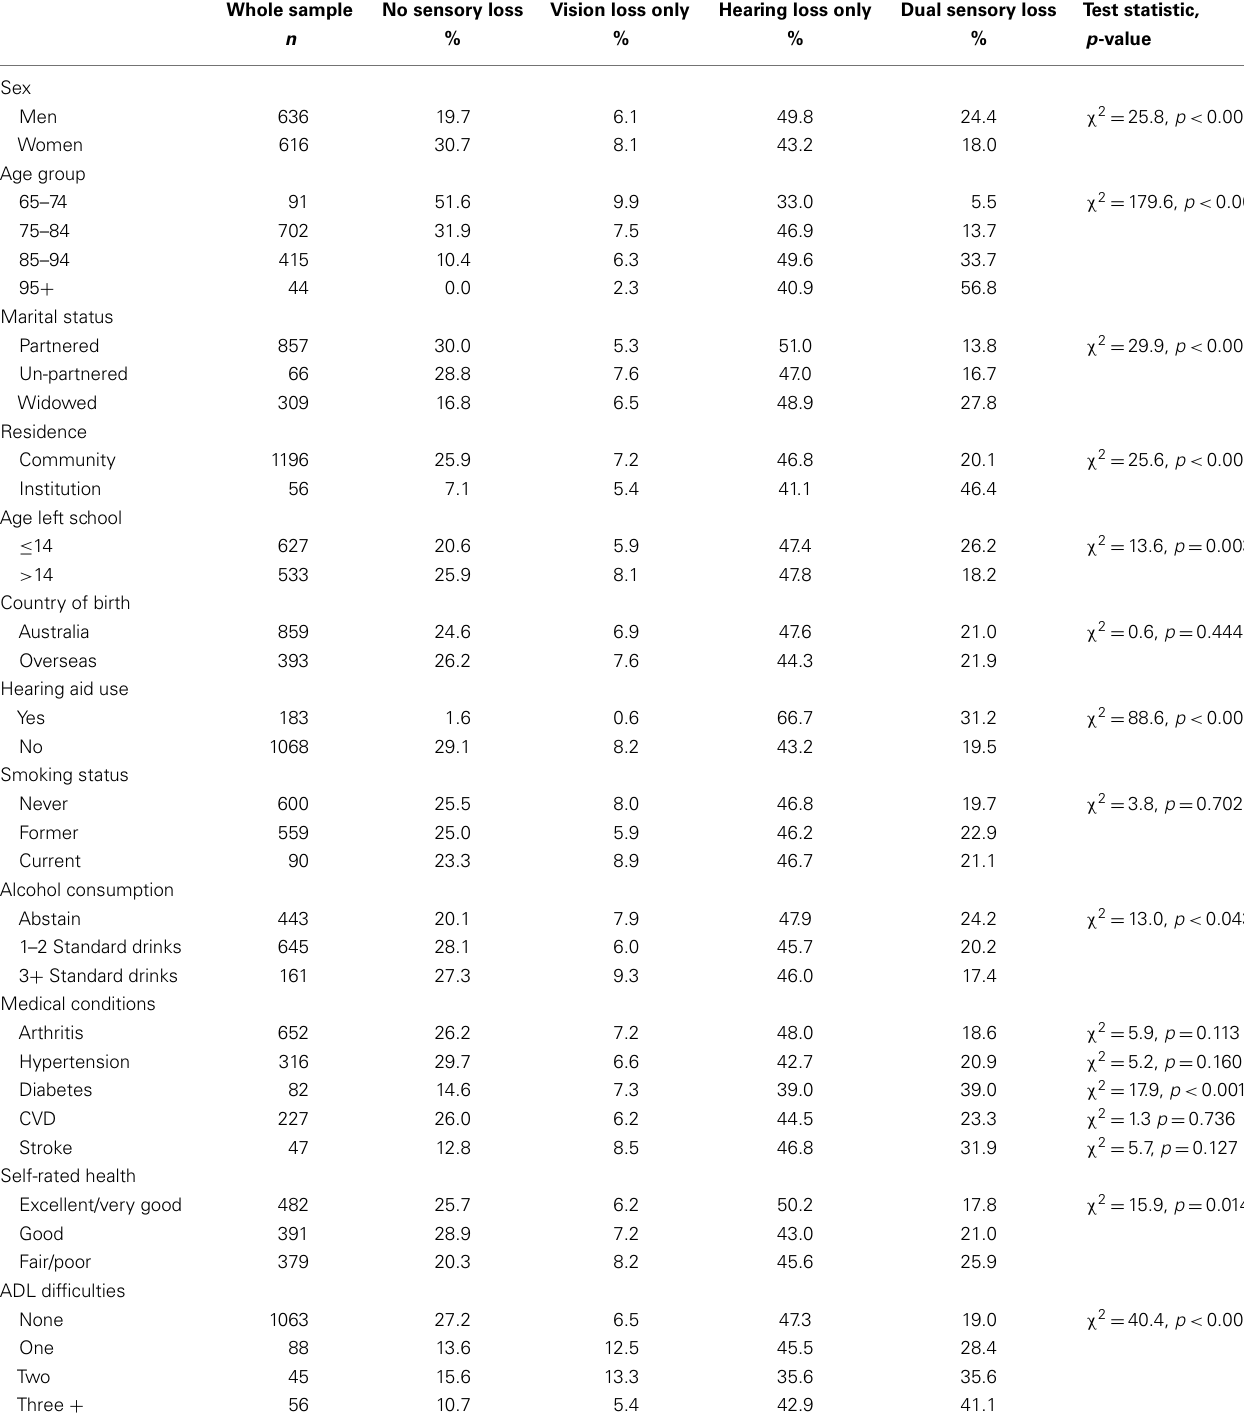
Table 1 | Sample characteristics at baseline by sensory loss ( N = 1252 a )